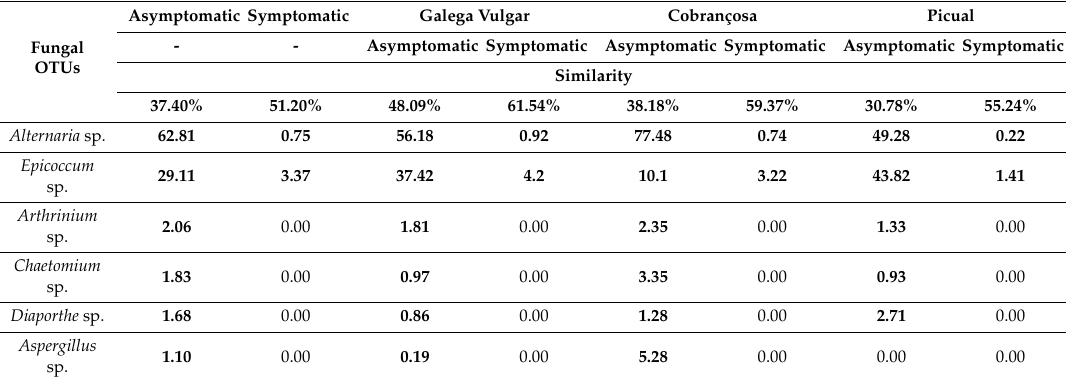
Table 1. Fungal OTUs identified by SIMPER analysis that contribute most to the similarities at each; health status (Asymptomatic and symptomatic) and cultivar (‘Galega vulgar’, ‘Cobrançosa’ and ‘Picual’). Bold values highlight values higher than